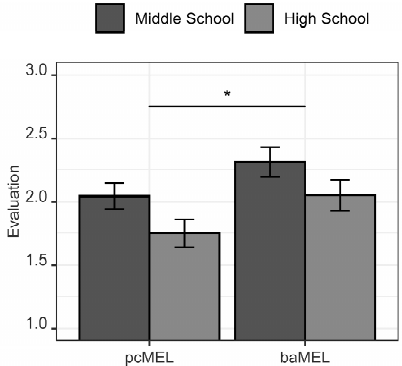
Figure 4. Evaluation scores (range: 1 (erroneous description)–4(critical evaluation)) for each instructional treatment. Errors bars indicated ± 1 standard error. Asterisk indicates a statistically significant difference between treatments, * p < 0.05.